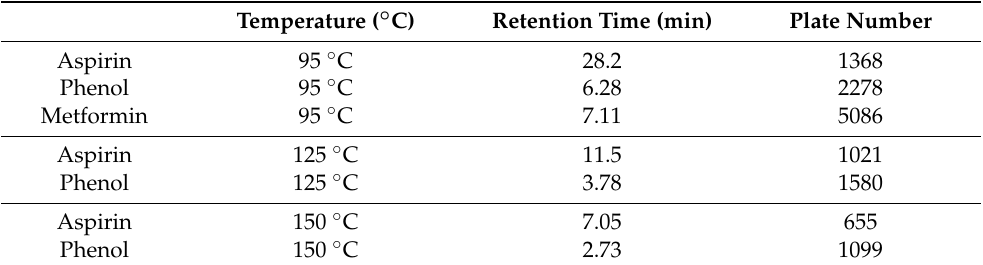
Table 1. Temperature effect on SBWC pressure, retention time, and plate number.